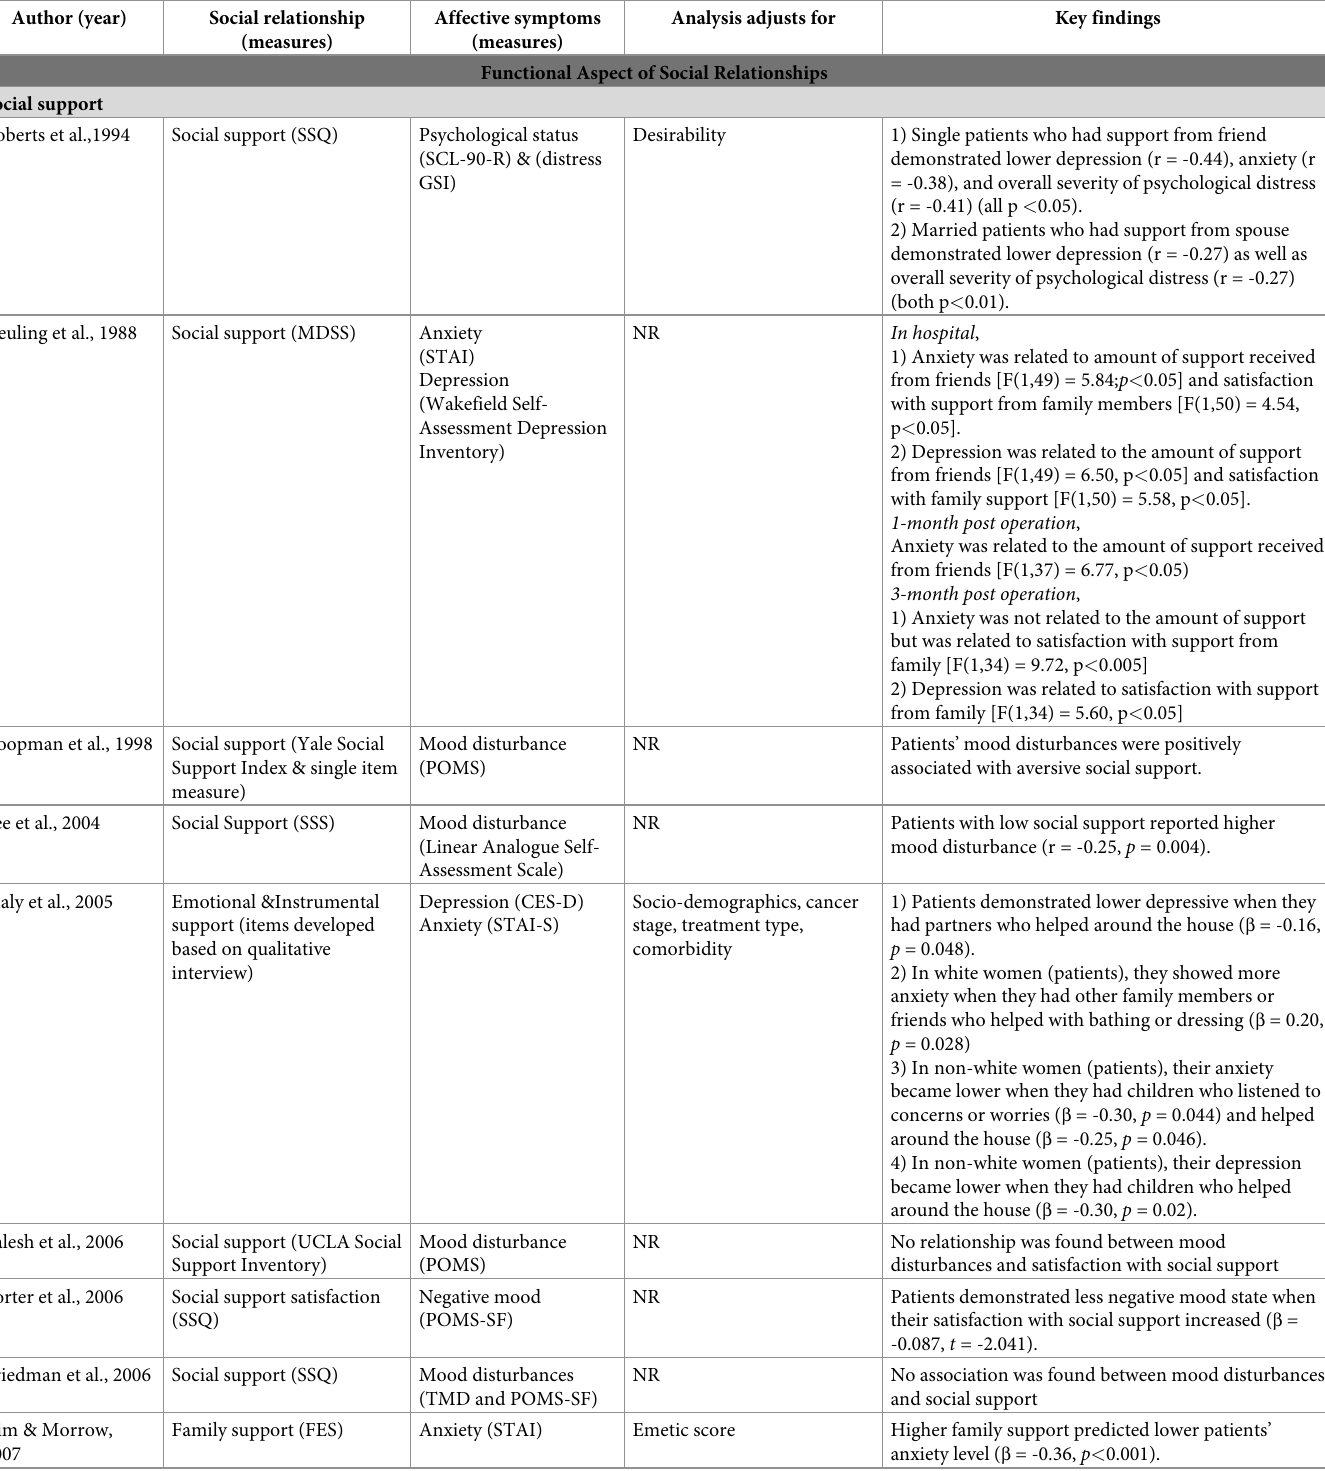
Table 3. Characteristics of studies regarding social relationships associated with the patient’s affective